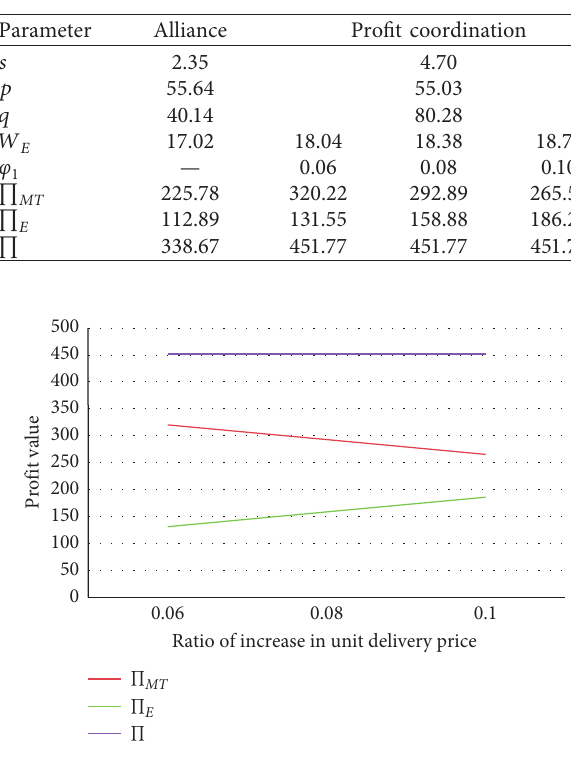
Table 7: Coordination result of the unit price of express service in semicentralized model 1.